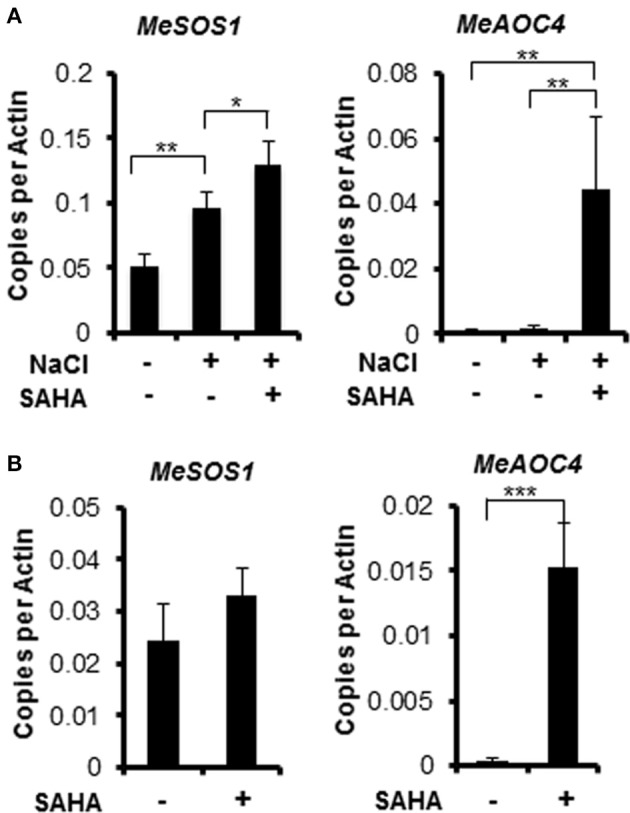
Expression profiles of MeSOS1 (Salt Overly Sensitive 1) and MeAOC4 (Allene Oxide Cyclase 4) genes using quantitative real-time RT-PCR (qRT-PCR) analysis. (A) Cassava plantlets were treated with 100 μM SAHA for 24 h then subjected to 200 mM salt medium for 2 h. (B) Cassava plantlets were treated with 100 μM SAHA for 24 h. Root samples were collected. Asterisks indicate significantly different means (*p < 0.05, **p < 0.005, ***p < 0.001) as determined with a t-test. Actin was used as reference gene. Error bars represent the means ± SD. Three independent biological replicates were performed for each condition.